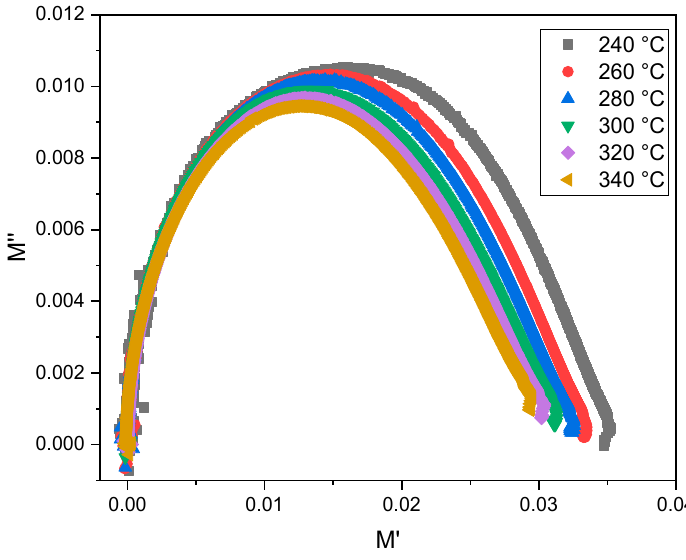
Figure 15. Nyquist plots for TZV15 sample at different temperatures.